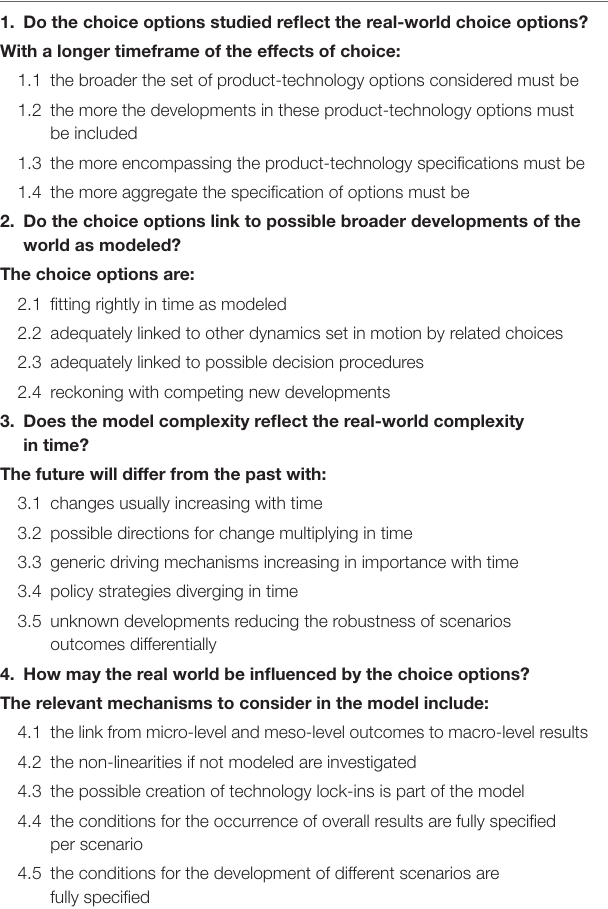
TABLE 2 | Checklist for predictive validity assessment of applied modeling